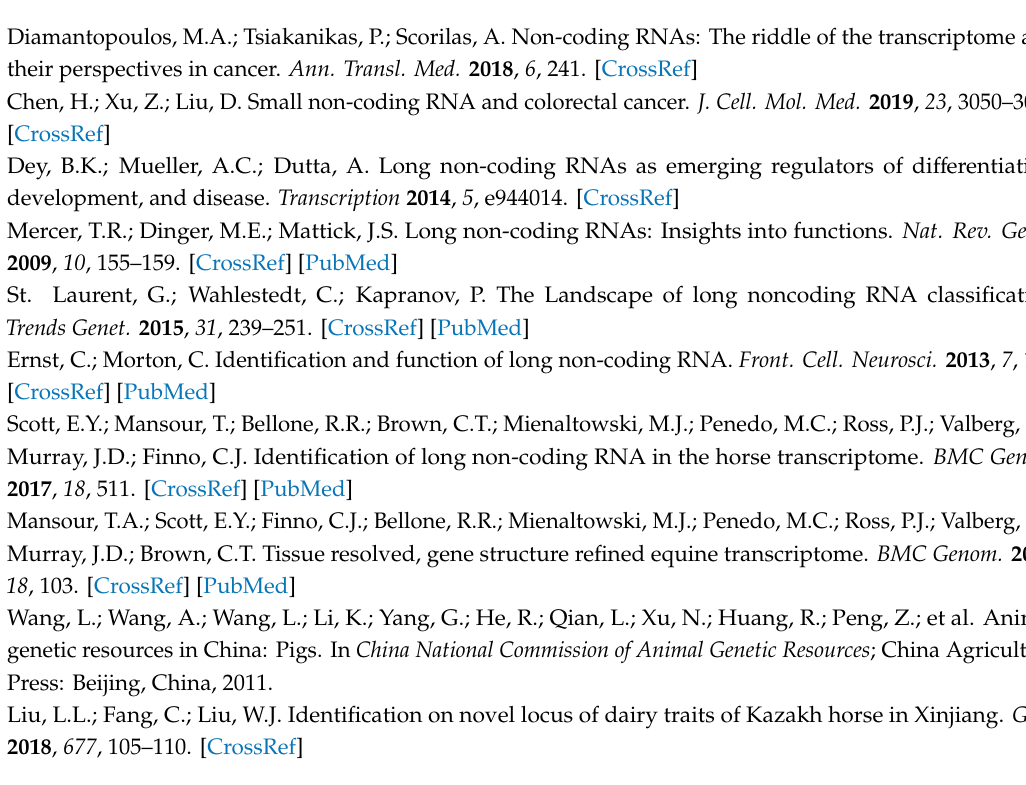
Figure A2. Classification of the novel lncRNAs.